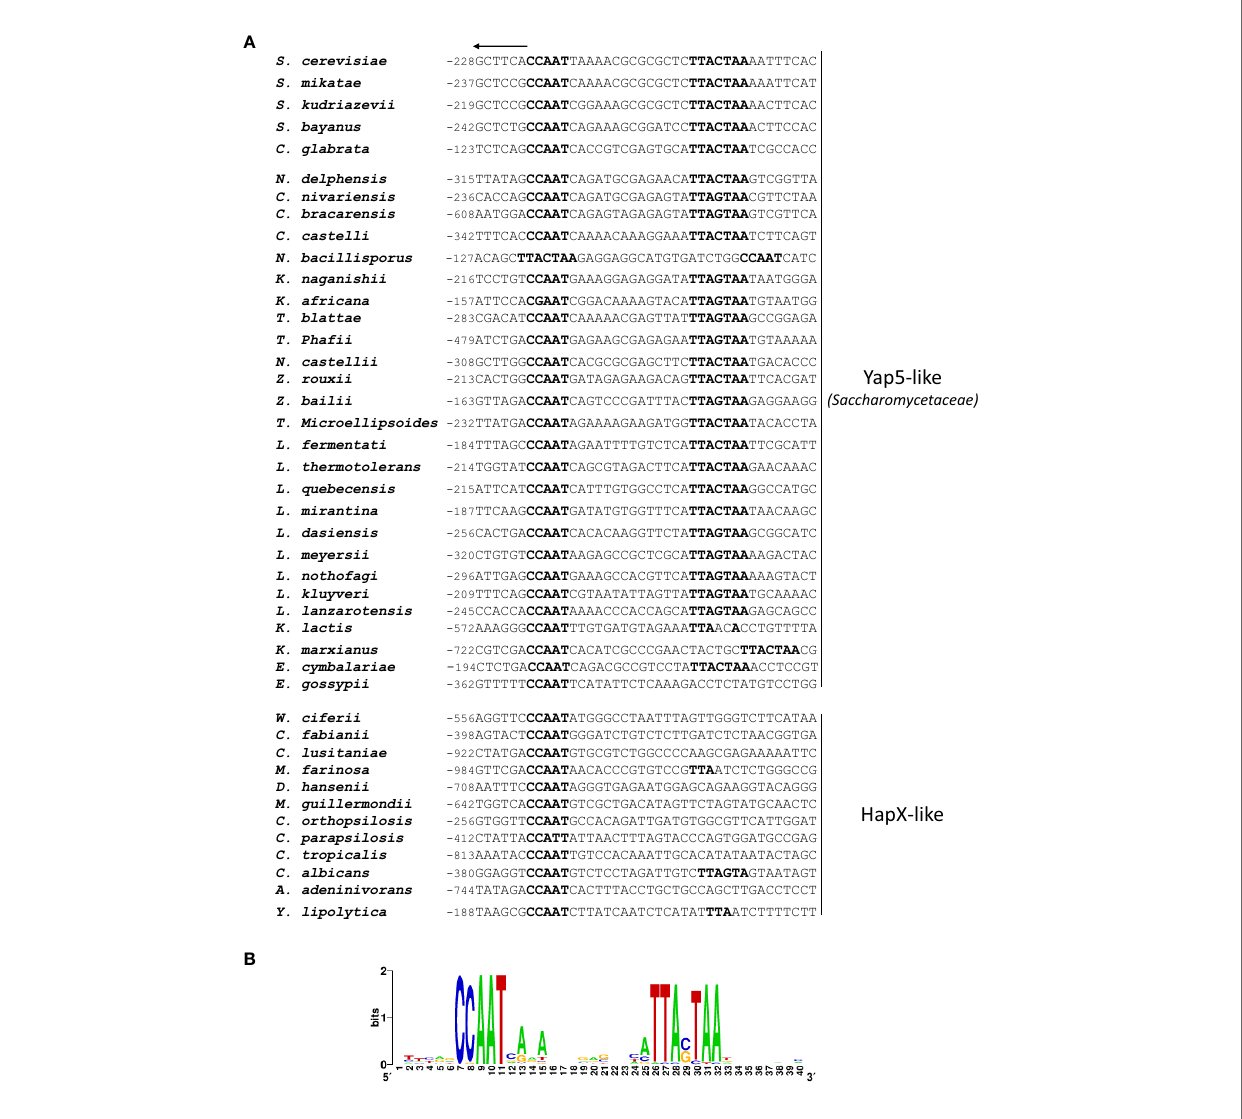
FIGURE 2 | Conservation of the CCAAT-YRE bipartite motifs in GRX4 orthologues from 43 Hemiascomycetes yeast species. (A) Alignment of the CCAAT-YRE bipartite motifs. The sequences were arbitrarily aligned based on the CCAAT box, except for N. bacillisporus in which the YRE was located upstream of the CCAAT. The CCAAT and YRE are represented in bold. All sequences are oriented 5 ’ -3 ’ from left to right. The arrow on top indicate the sense of transcription of GRX4 , i.e. the arrow oriented to the left indicates that the CCAAT-YRE motif is on the minus (non coding) strand. The position relative to the ATG of the gene is indicated. (B) Seqlogo of the CCAAT-YRE alignments in the sequences from the Saccharomycetaceae species ( “ Yap5-like ” species) presented in panel (A) , excluding N. bacillisporus